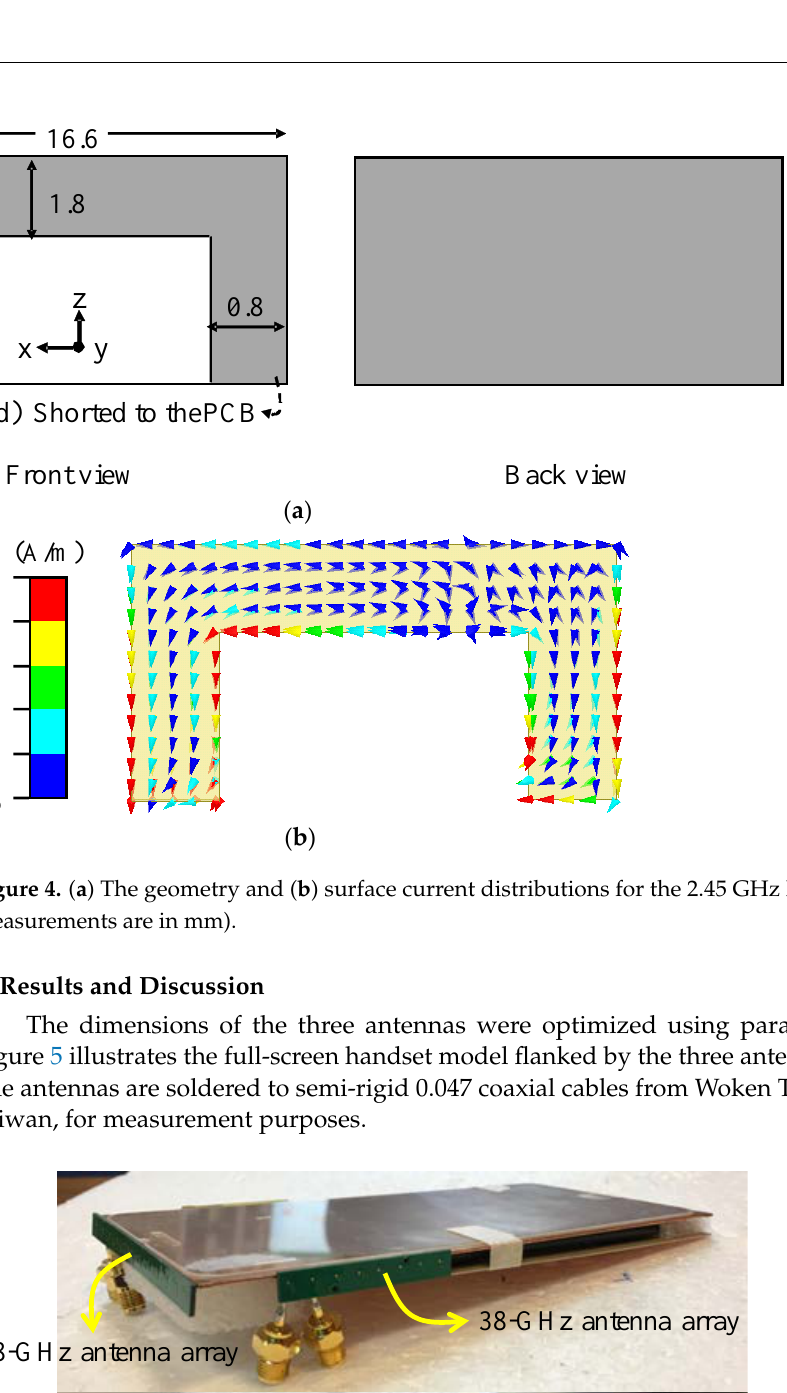
( c ) Figure 3. Geometry of ( a ) the 38 GHz 1 × 8 coupled patch antenna array and ( b ) the unit element (all measurements are in mm). ( c ) The surface current distributions at 38 GHz. Figure 4a details the topology of the 2.45 GHz antenna. Along with the current pathway on the PCB ground, the proposed antenna has a half-wavelength loop printed on a 0.6-mm-thick FR4 substrate ( ε r = 4.4 and tan δ = 0.02). The WLAN requires a significantly lower frequency than millimeter-wave applications, so it is challenging to integrate this antenna with the two aforementioned antenna arrays. Thus, a loop antenna was designed to suit the design space on the flank. The current distributions are shown in Figure 4b. The currents along the horizontal segment change direction at the midpoint, while the currents along the vertical segments show relatively strong magnitudes, which follows the operating principle of a half-wavelength loop. Additional studies were performed to create a meandered inverted L antenna (ILA) that resonated at 2.45 GHz. However, narrow impedance bandwidths were observed for the meandered ILA (2.43– 2.46 GHz in terms of a − 10 dB reflection coefficient). Although meandered ILAs are a